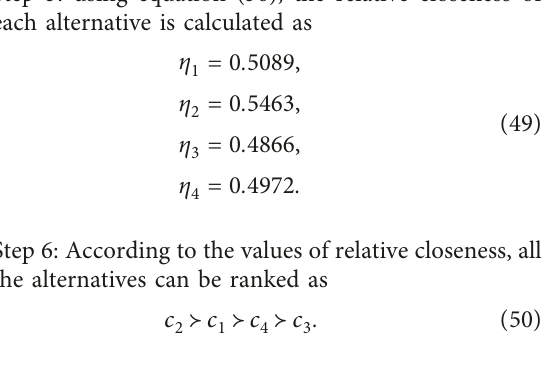
Table 1: The LPFDM for the selection of firewall